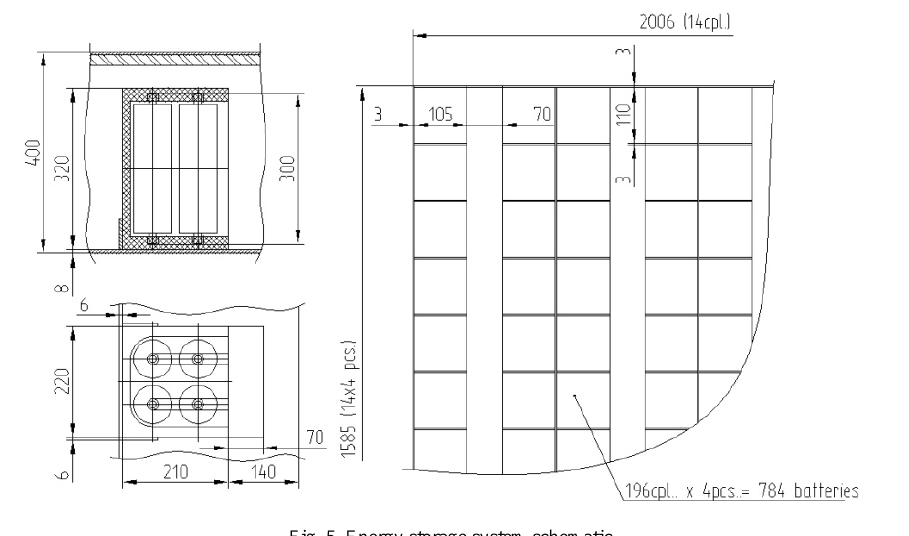
Fig. 5. Energy storage system schematic